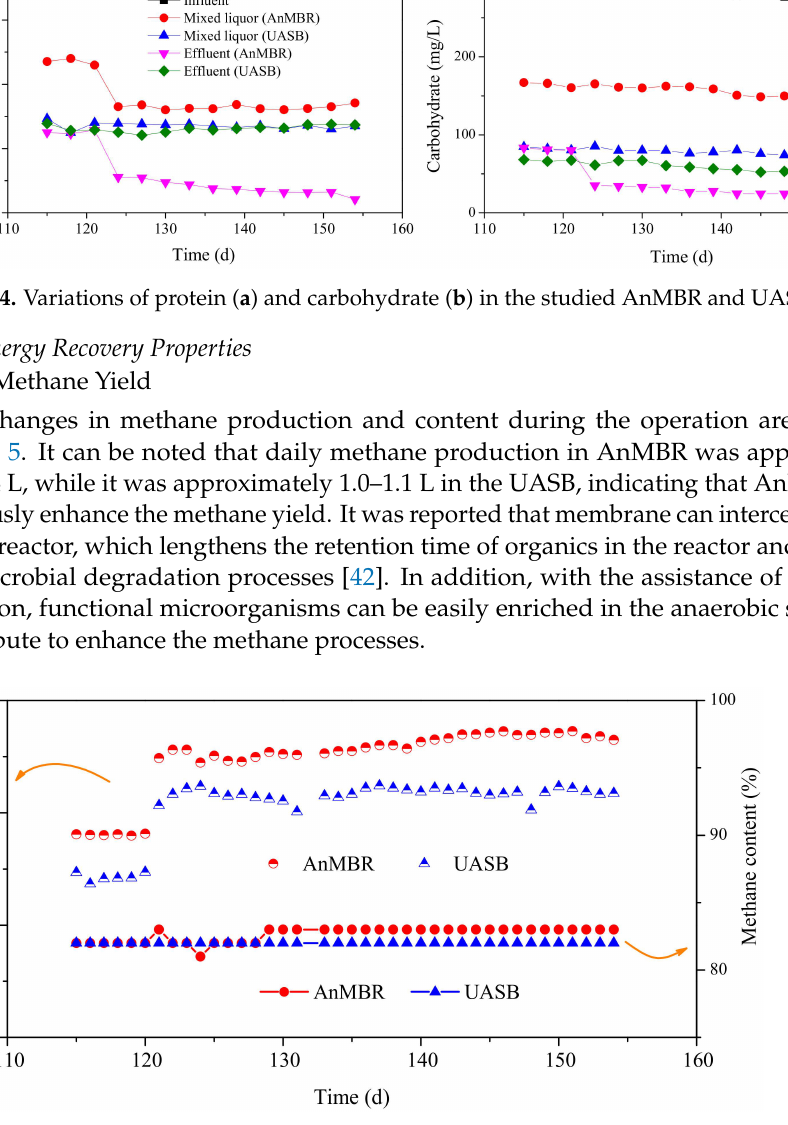
Figure 5. Methane production in AnMBR and